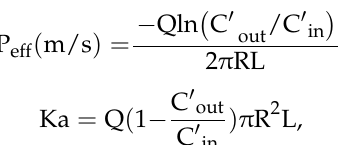
s1, Figure S1: The standard curve of CAPB and CAPC across caco-2 cell monolayer was detected by LC-MS. Figure S2: CAPs inhibited the proliferation of caco-2